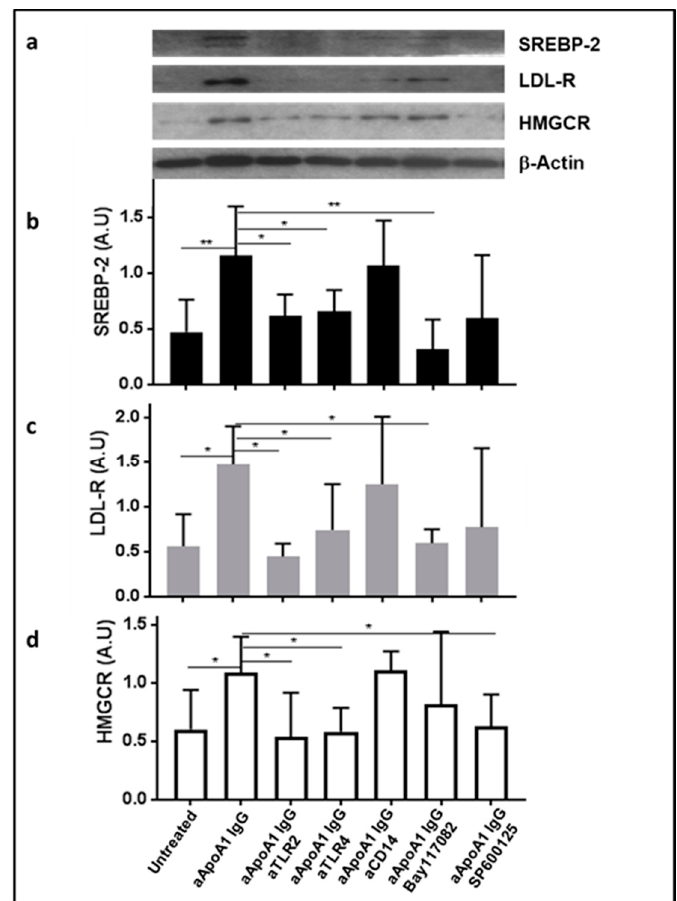
Figure 4. The impact of anti-ApoA-1 IgG on cholesterol metabolism is mediated by TLR2, TLR4, Nf-KB, and AP-1 transcription factors. Western blot-derived results showed that anti-ApoA-1 IgG-mediated upregulation of SREBP2, LDL-R, and HMGCR on human monocyte-derived macrophages (HMDM) is significantly reduced by blocking TLR2 and TLR4 with specific blocking antibodies. Blocking NF-kB and AP-1 using the specific inhibitors BAY117082 and SP600125 respectively provided similar results. ( a ) One of five representative Western blots is shown. ( b – d ) Data are expressed as mean ± SD of band intensity volume / actin intensity volume from five di ff erent experiments ( n = 5). p -values were calculated using the Student’s t -test: * p < 0.05, ** p < 0.01.